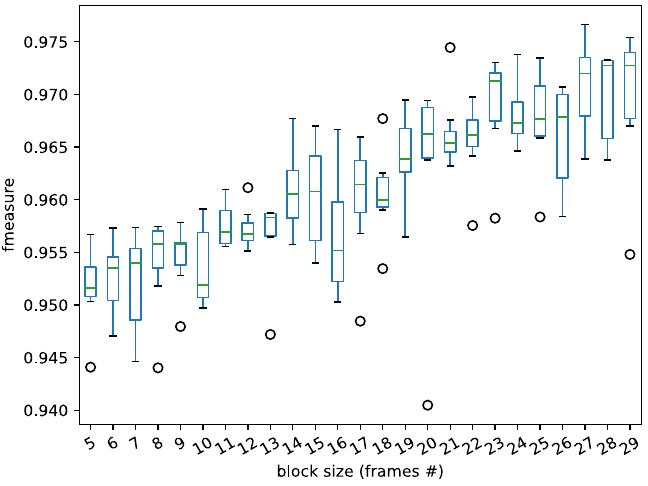
Figure 16. Performances of different block sizes as input of LRCN for the RWC